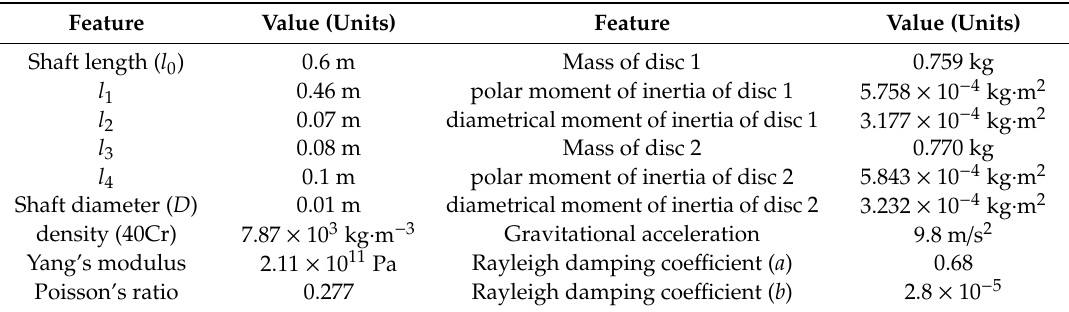
Table 1. Parameters of the two-disc